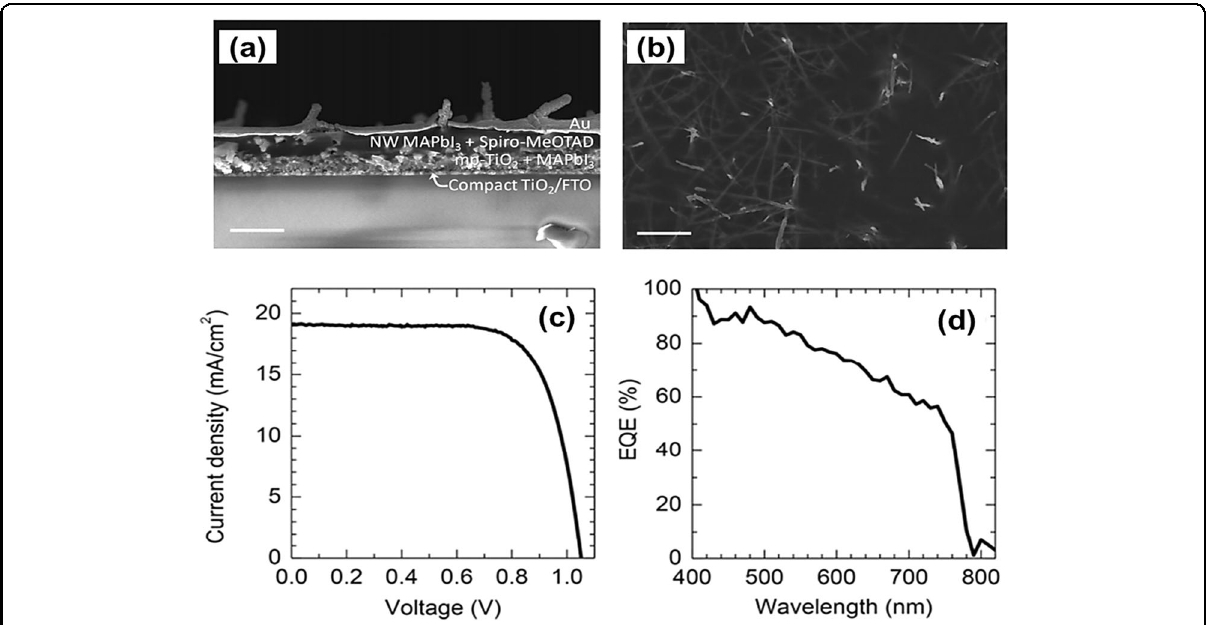
Fig. 6 Application of 1D morphological MHP NWs in solar cells. a Cross-sectional and b top-view SEM images of a solar cell device employing MAPbI 3 NWs. c Current-voltage curve and d EQE of the device based on MAPbI 3 NWs. Reproduced with permission from ref. 74 . Copyright 2015, American Chemical